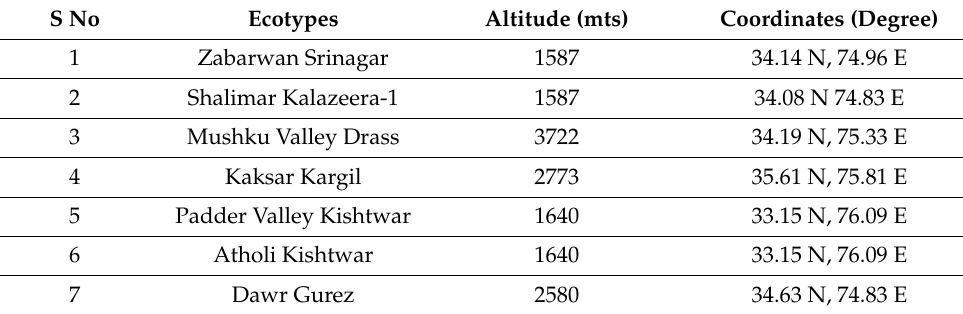
Table 5. Details of collection sites of Kala zeera